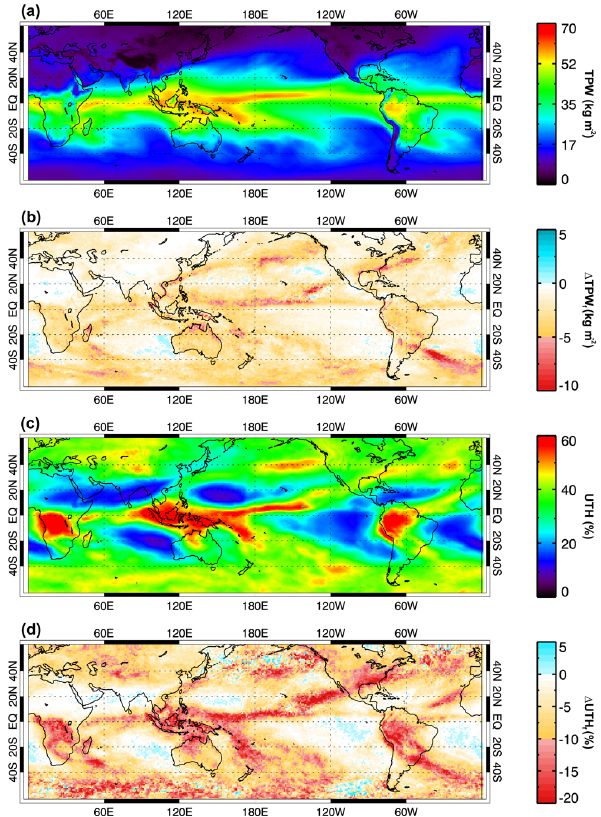
Fig. 1. Geographic distributions of one-month (15 December 2006– 15 January 2007) means of (a) TPW, (b) difference between cloud- free TPW and all-sky TPW, (c) UTH, and (d) difference between cloud-free UTH and all-sky